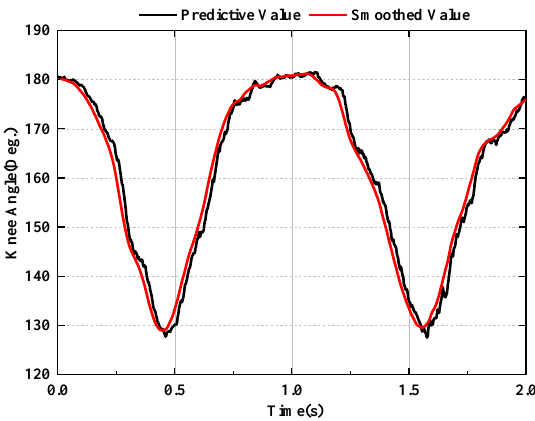
Figure 11. Measured value and regression value.